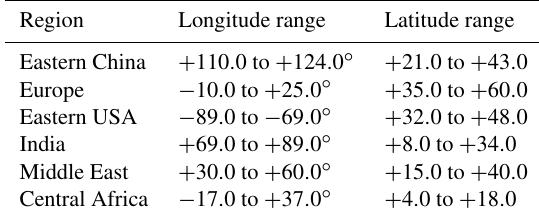
Table A1. Definition of the regions in Fig. 14. Region Longitude range Latitude range Eastern